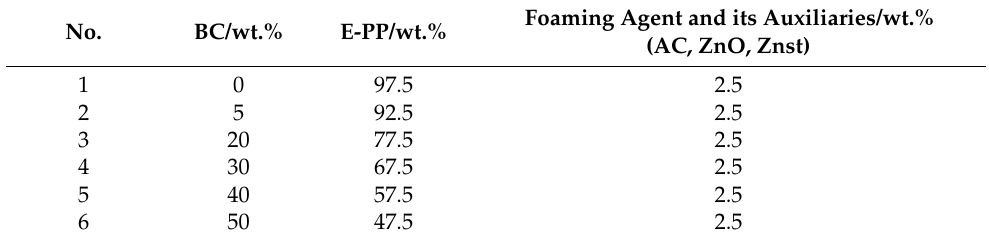
Table 1. The mixing component content of foamed E-PP/BC composites. No. BC/wt.% E-PP/wt.%